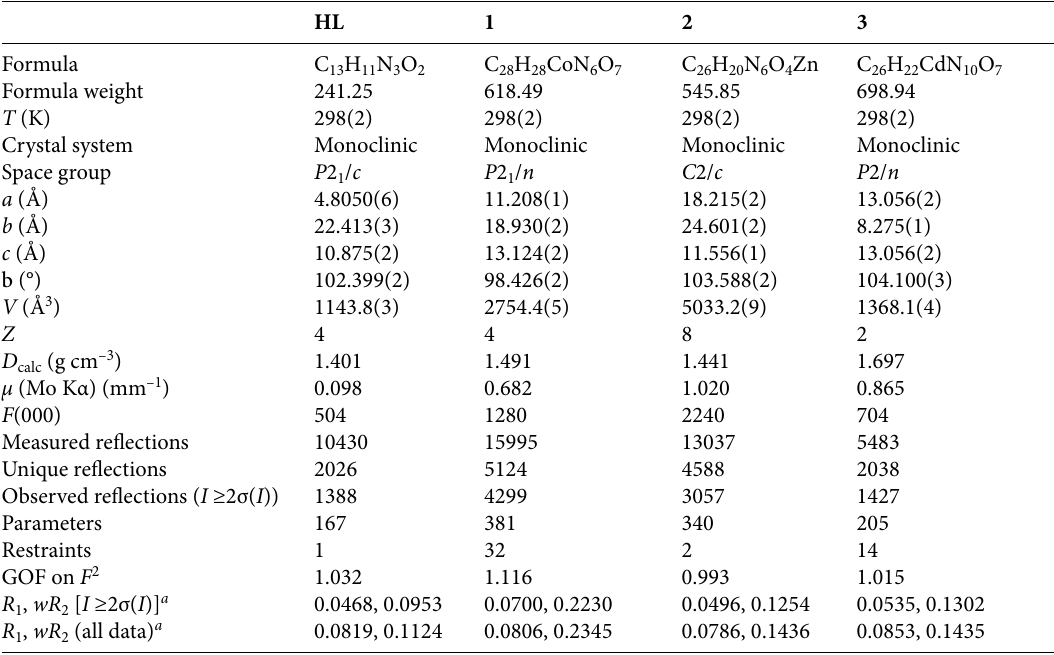
Table 1. Crystallographic and refinement data for HL and its metal